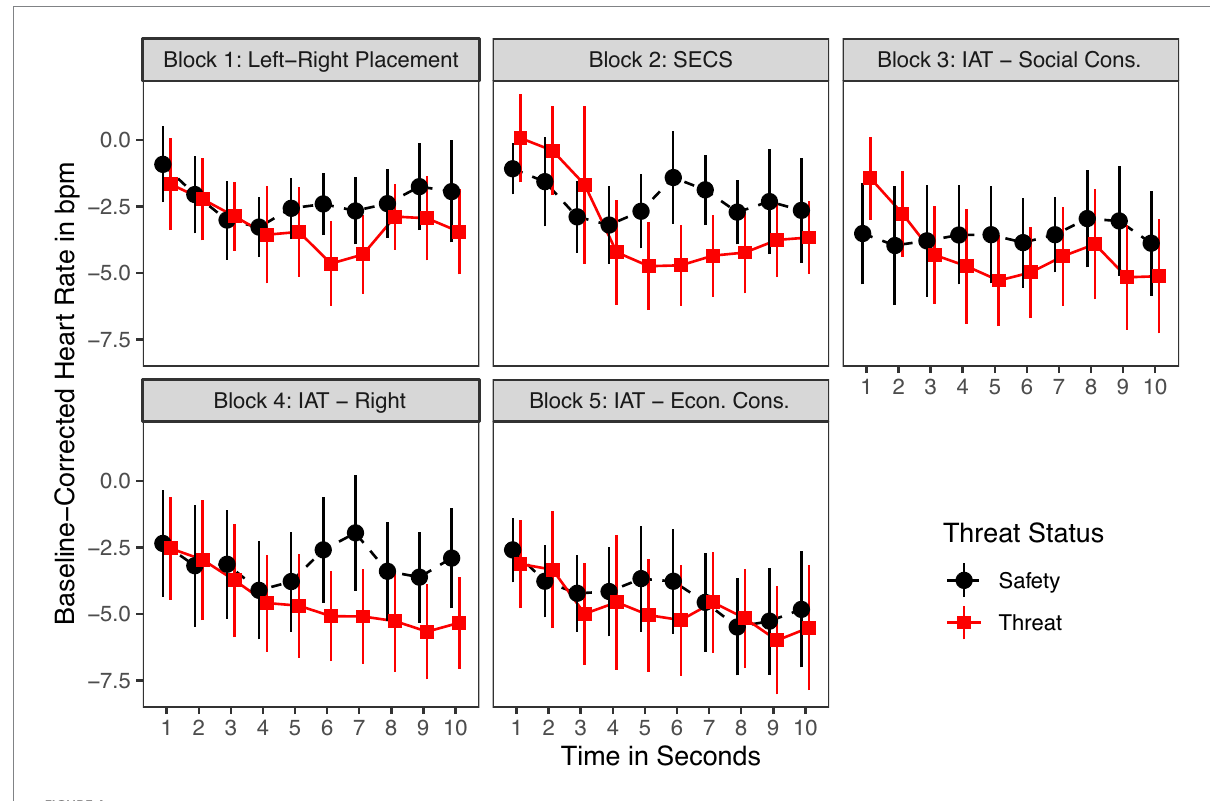
FIGURE 4 Mean baseline-corrected heart rate response per block for 10s after the onset of the threat and saftey phase. Averages are shown separately for experimental conditions. Participants under threat are indicated by red lines and participants under safety by black lines. In addition, 90% confidence intervals are